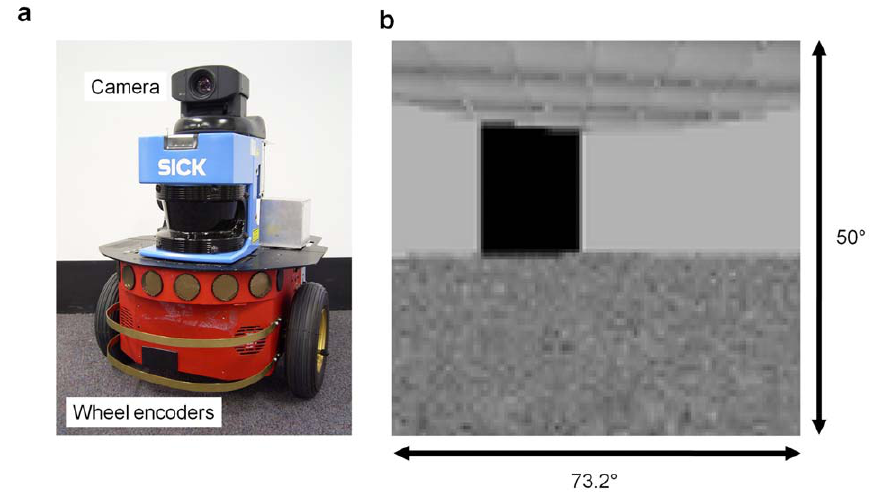
Figure 2. The simulated robot and sample visual field. (a) The real-life robot that was modeled was a Pioneer 2DXe from MobileRobots, with a forward facing camera providing the visual sensory input, and wheel encoders providing self-motion information. (b) A captured visual scene as the robot perceives the world in the circular arena, with approximately one cycle per degree visual acuity.